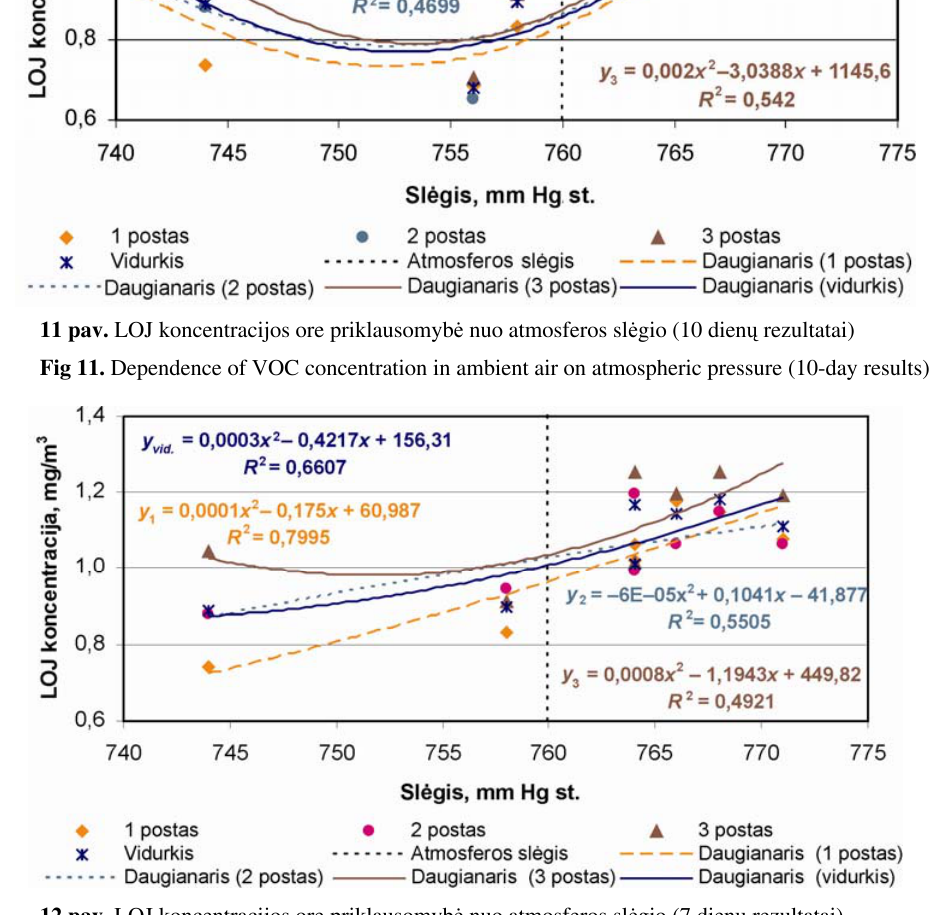
Fig 12. Dependence of VOC concentration in ambient air on atmospheric pressure (7-day